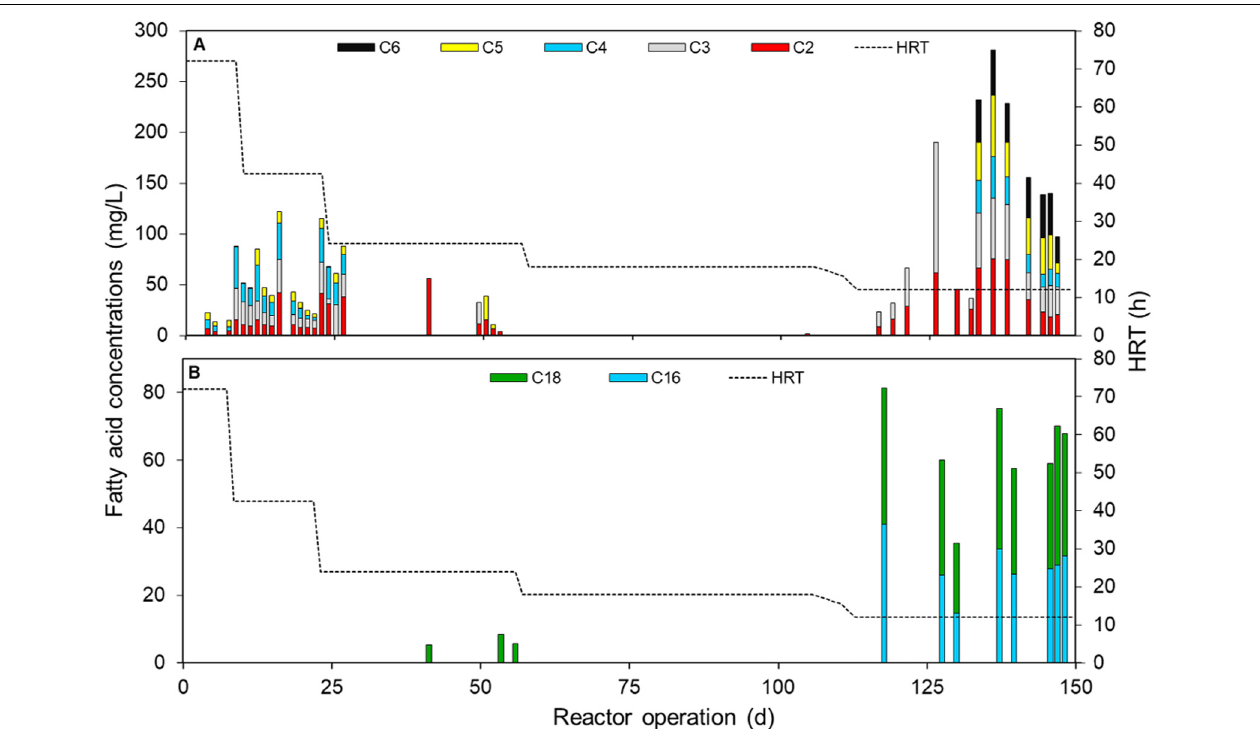
FIGURE 4 | Profiles of (A) volatile fatty acids (VFA), i.e. acetate (C2), propionate (C3), butyrate and iso-butyrate (C4), valerate (C5) and caproate (C6), and (B) long chain fatty acids (LCFA), i.e. palmitate (C16:0), and stearate (C18:0), in DSC-FF reactor effluent at the different HRTs of 72, 42.5, 24, 18, and 12 h. LCFAs myristate (C14:0), oleate (C18:1), and linoleate (C18:2) were not found in the liquid